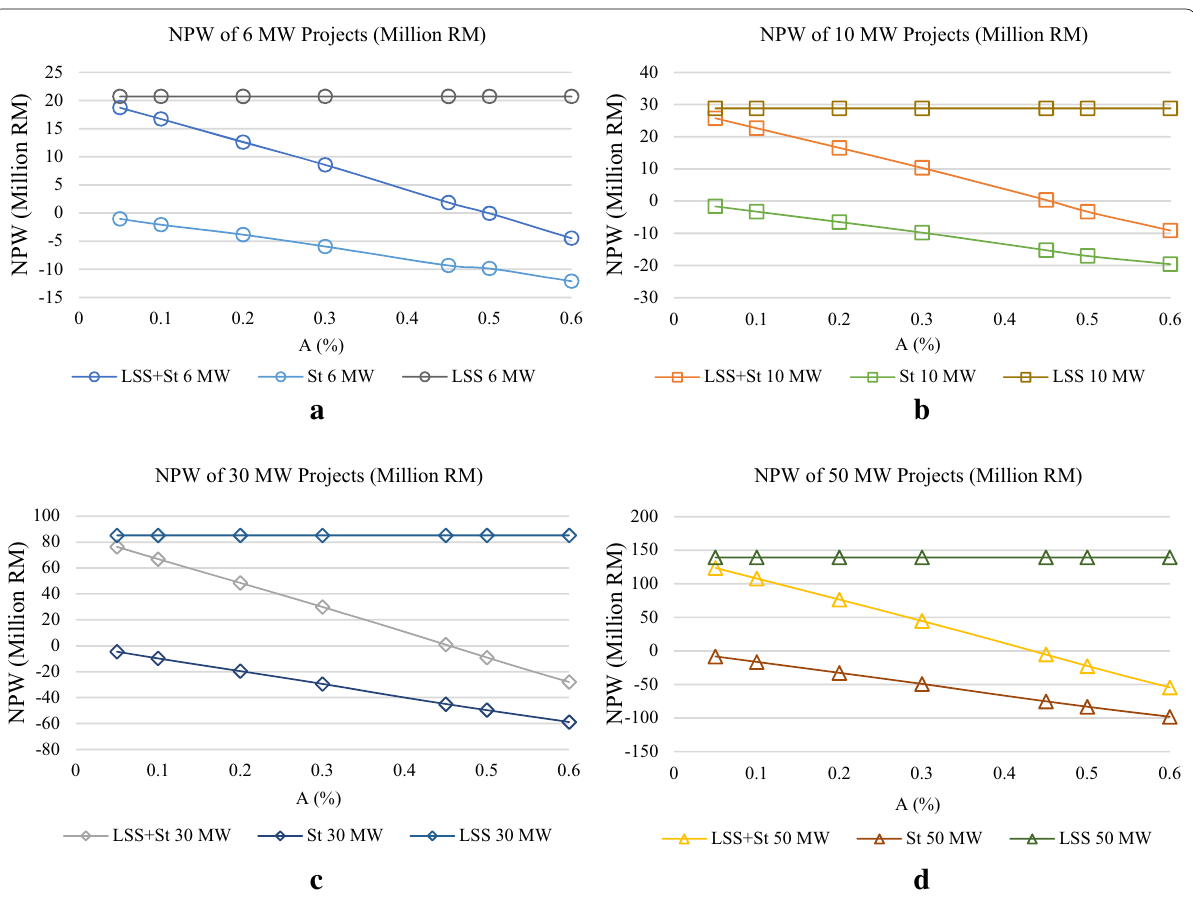
Fig. 4 Net present worth of the different investment types for each LSS capacity in Pahang. a 6-MW projects, b 10-MW projects, c 30-MW projects, d 50-MW